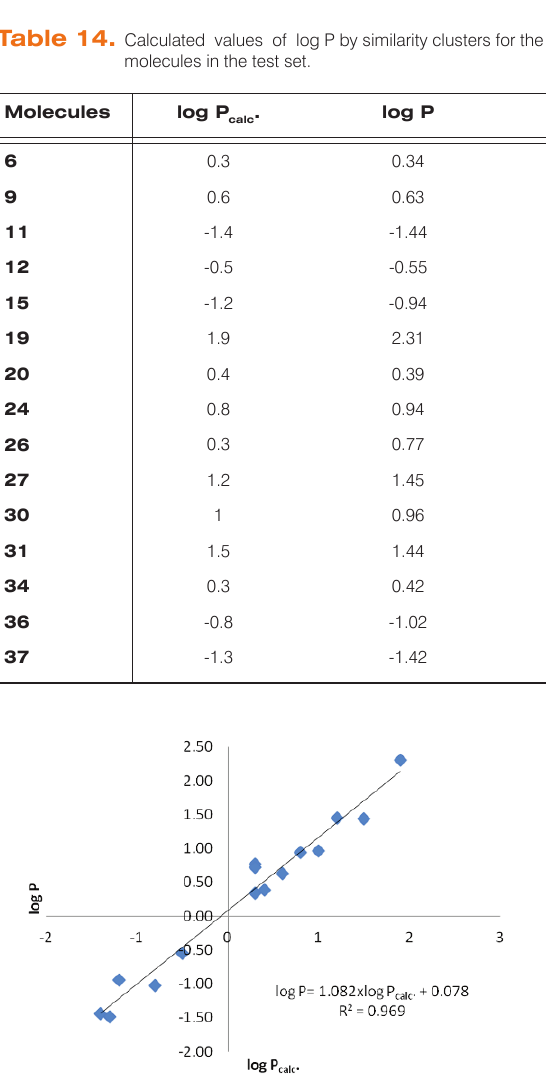
Figure 9. Plot of Log P vs. log P